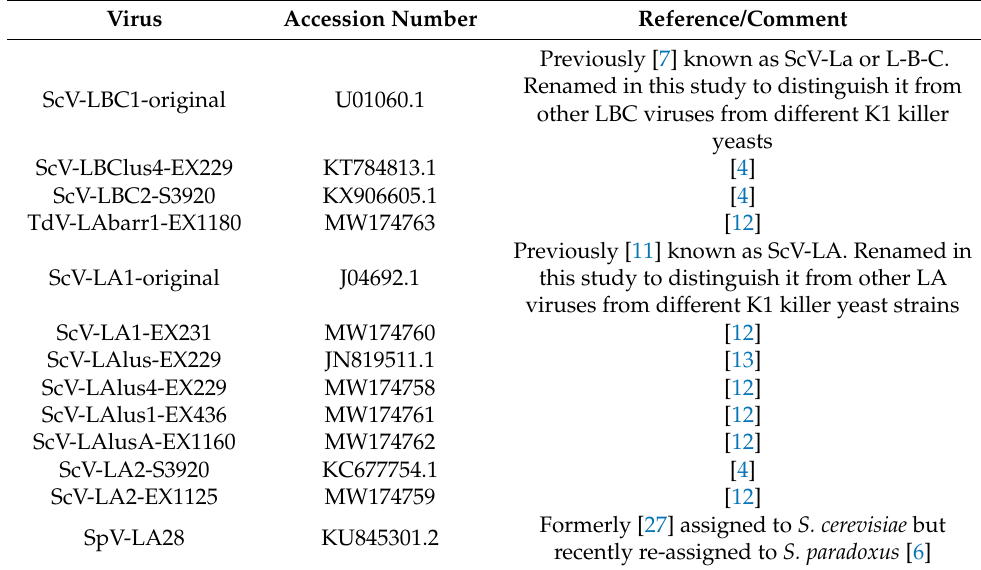
Table 2. Previously known nucleotide sequence of LBC and LA viruses used in this study.